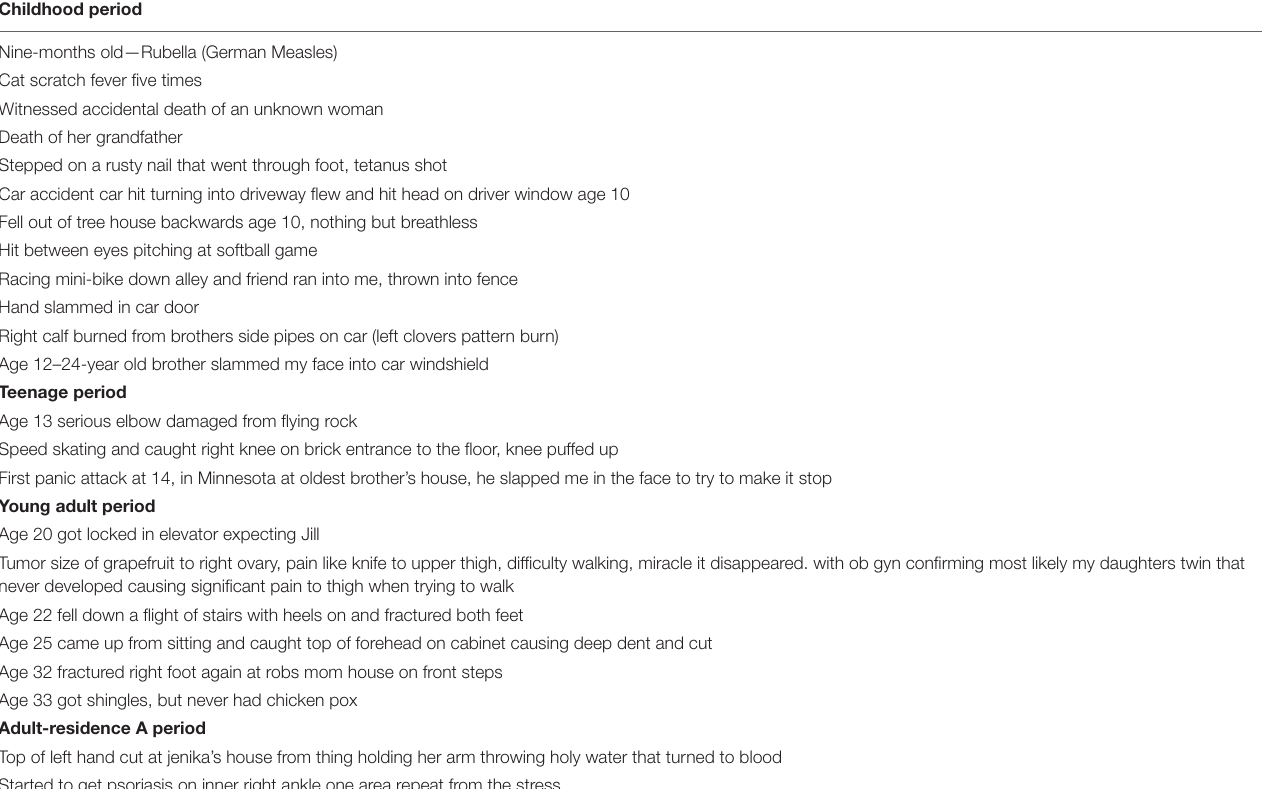
TABLE 4 | Primary percipient’s most noteworthy dis-ease events across life periods. Childhood